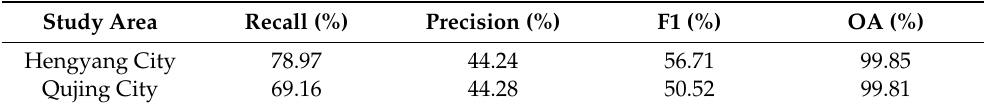
Table 8. Accuracy